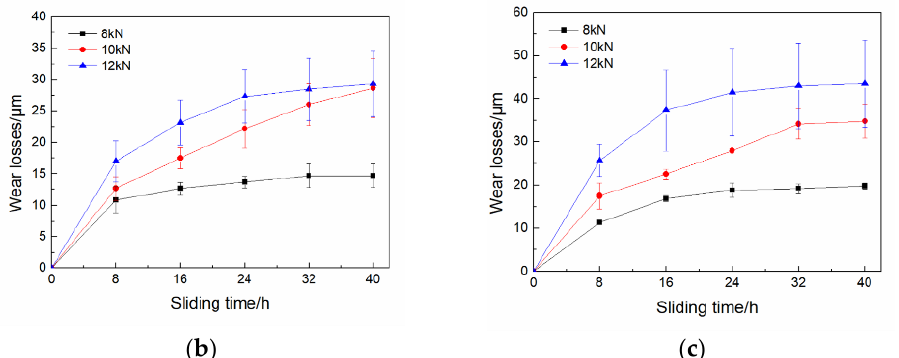
Figure 9. Wear of the piston skirts under different loads: ( a ) total wear of the piston skirts at varied heights, ( b ) and ( c ) wear of the piston skirts versus time at the height of 42 and 63 mm, respectively.